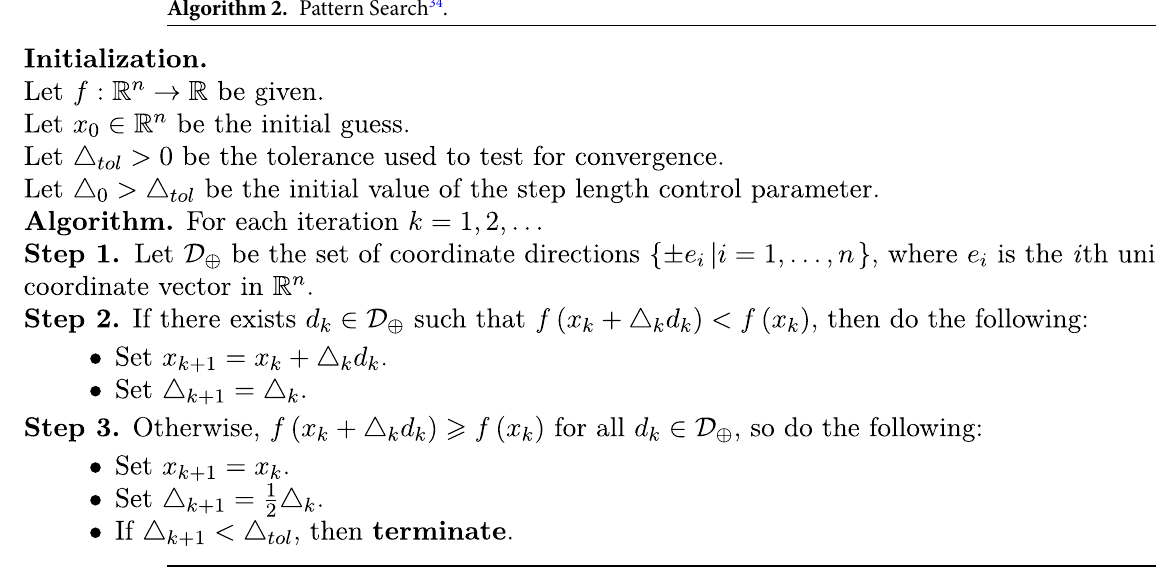
Algorithm 2. Pattern Search 34